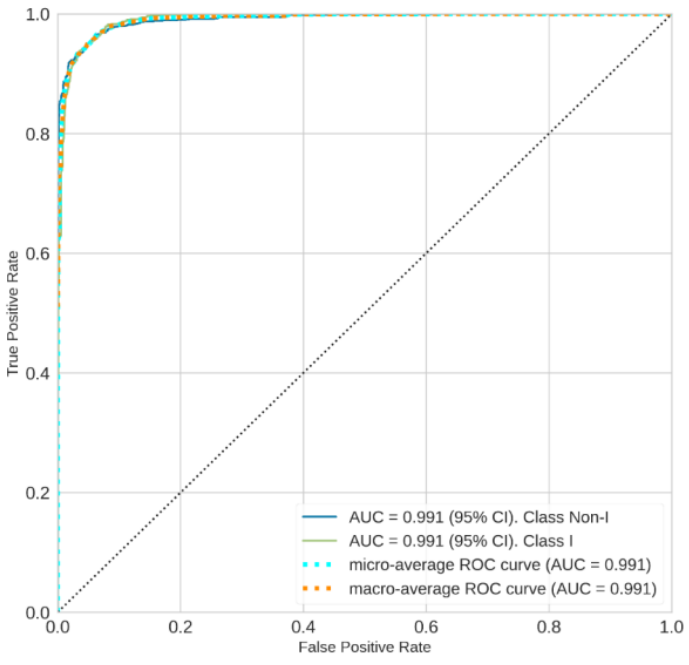
Figure 14. ROC curves of XGBoost Classifier for two classes (‘I’ vs. ‘Non-I’).